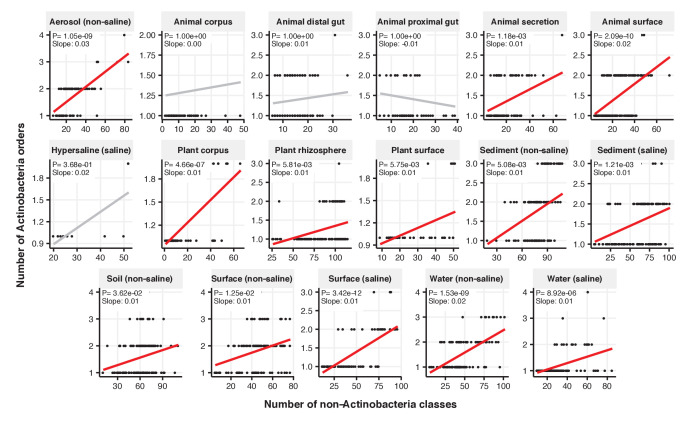
Focal-lineage diversity as a function of community diversity across biomes in Actinobacteria.Linear models are shown for the number of orders per class (y-axis) as a function of community diversity (non-focal classes, x-axis) in each of the 17 environments (EMPO3 biomes). Only environments containing the focal lineage are shown. Significant positive diversity slopes are shown in red (linear models, p<0.05, Bonferroni corrected for 17 tests), and non-significant in grey.